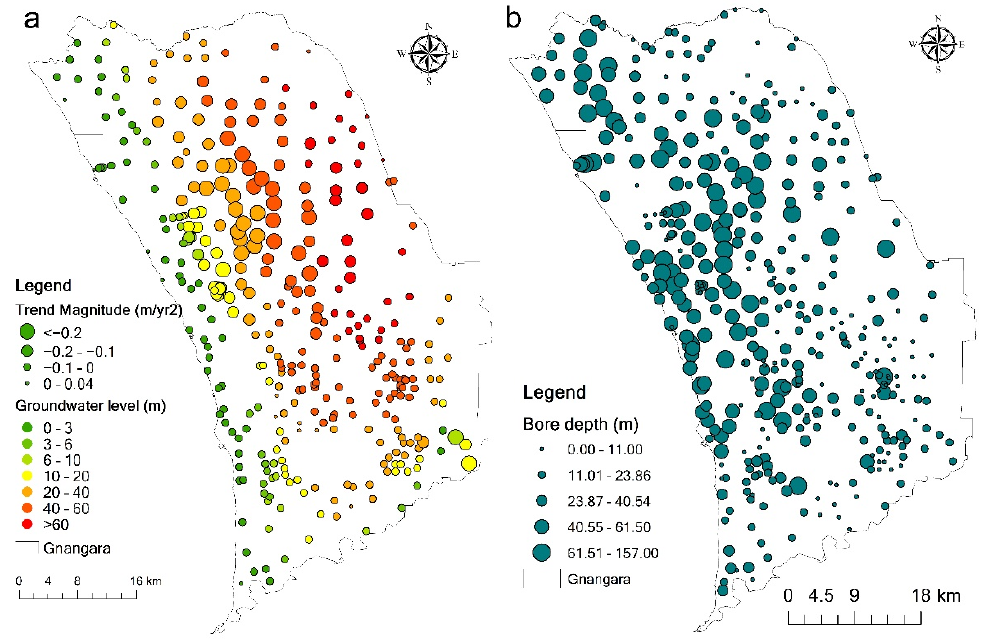
Figure 11. ( a ) Trend magnitude of groundwater level; ( b ) bore depths in the Gnangara region.